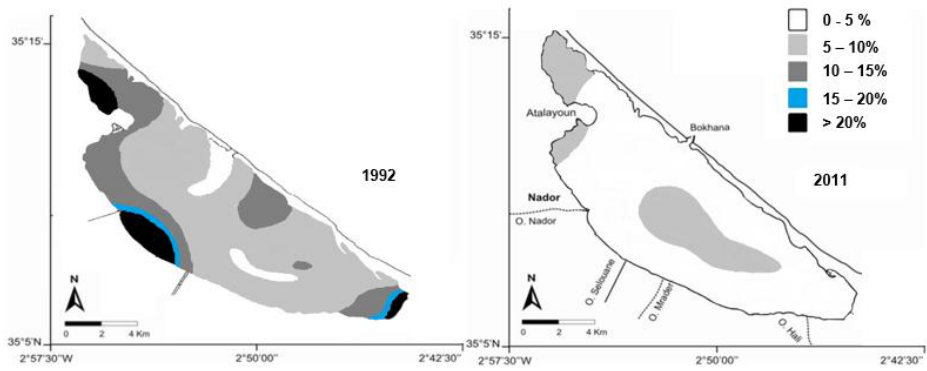
Figure 10. Changes in OM distribution in Nador lagoon seabed from 1992 [18] to 2011: figure redrawn.